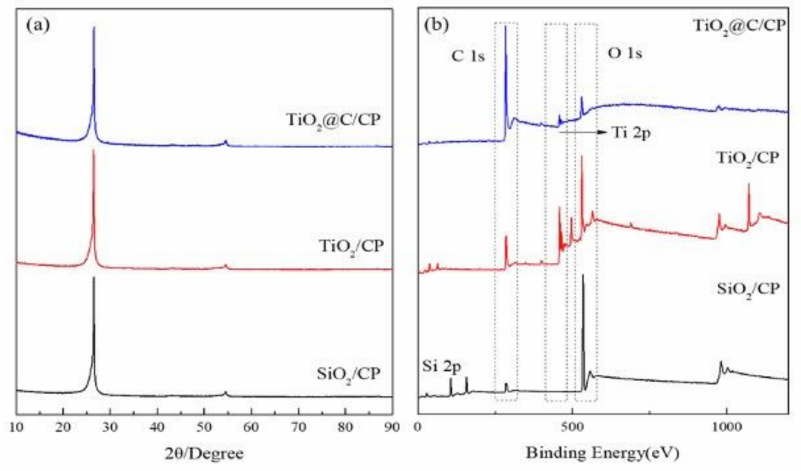
Figure 2. ( a ) XRD patterns and ( b ) XPS spectra of the SiO 2 , TiO 2 , and TiO 2